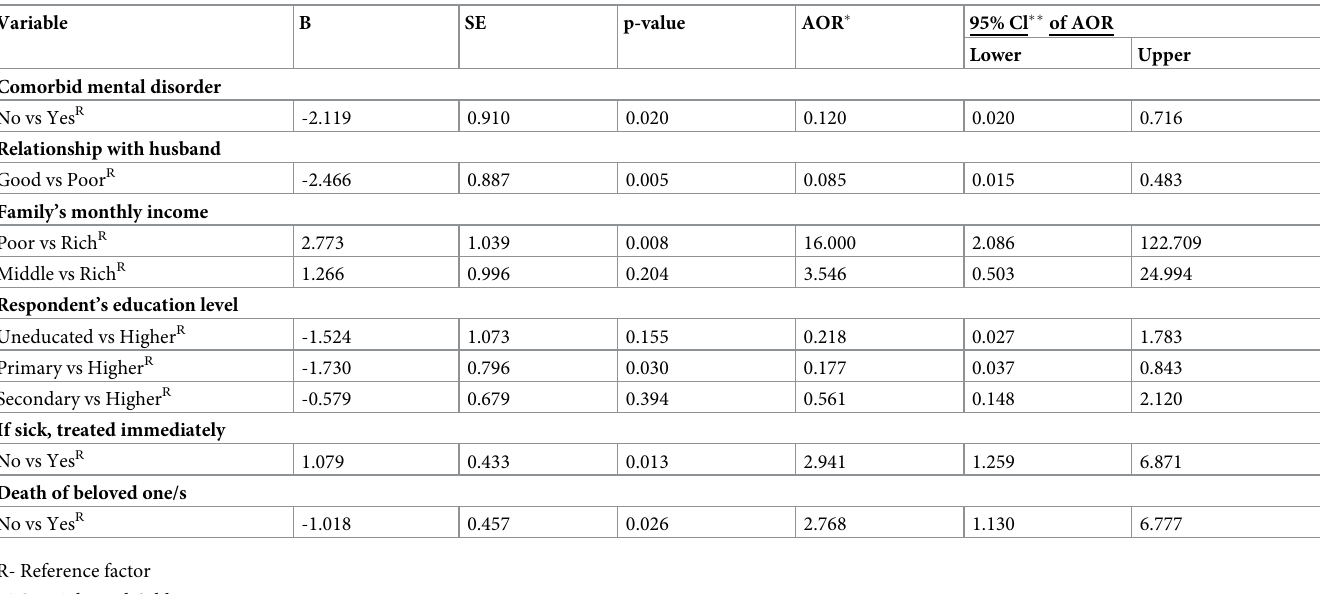
Table 2. Effect of socio-economic, familial and psychological factors on BPD among married women in Rajshahi City,